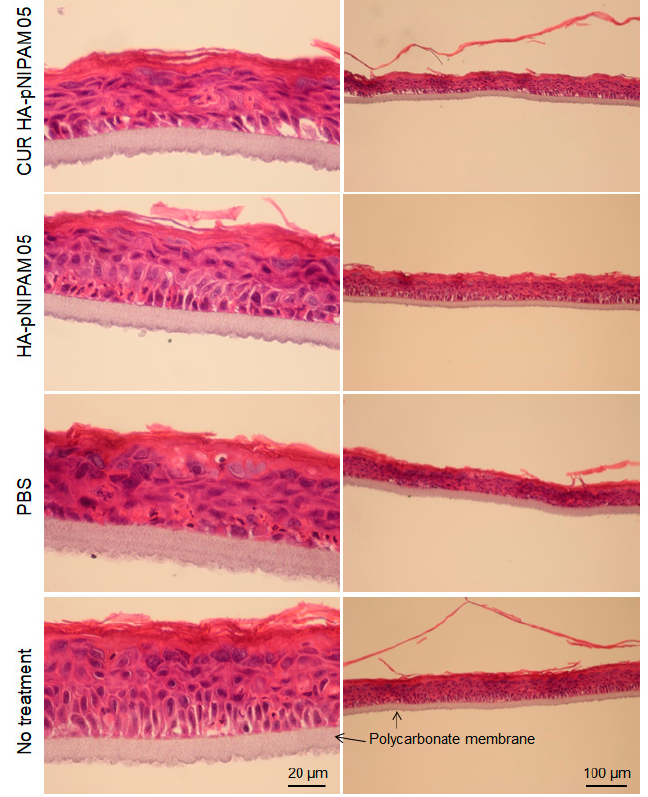
Figure 5. Histological analysis for acute skin irritation test. Hematoxylin and Eosin (H&E) stained EpiSkin ® . The scale bars for each left and right column indicate 20 µm and 100 µm, respectively.